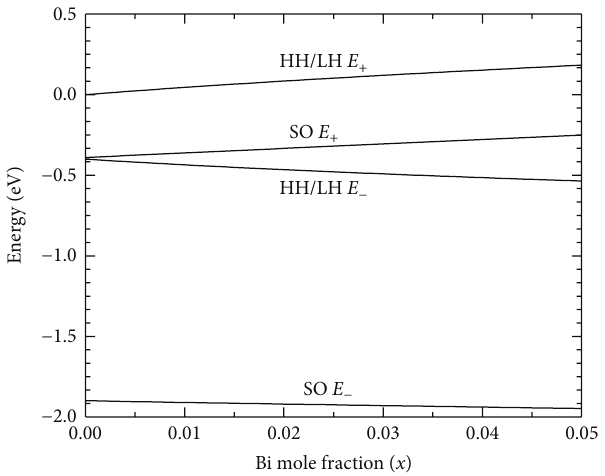
Figure 2: Position of the 𝐸 + and 𝐸 − related heavy/light hole and spin-orbit split-off bands as a function of Bi mole fraction for InAs 1−𝑥 Bi 𝑥 , calculated using VBAC model.